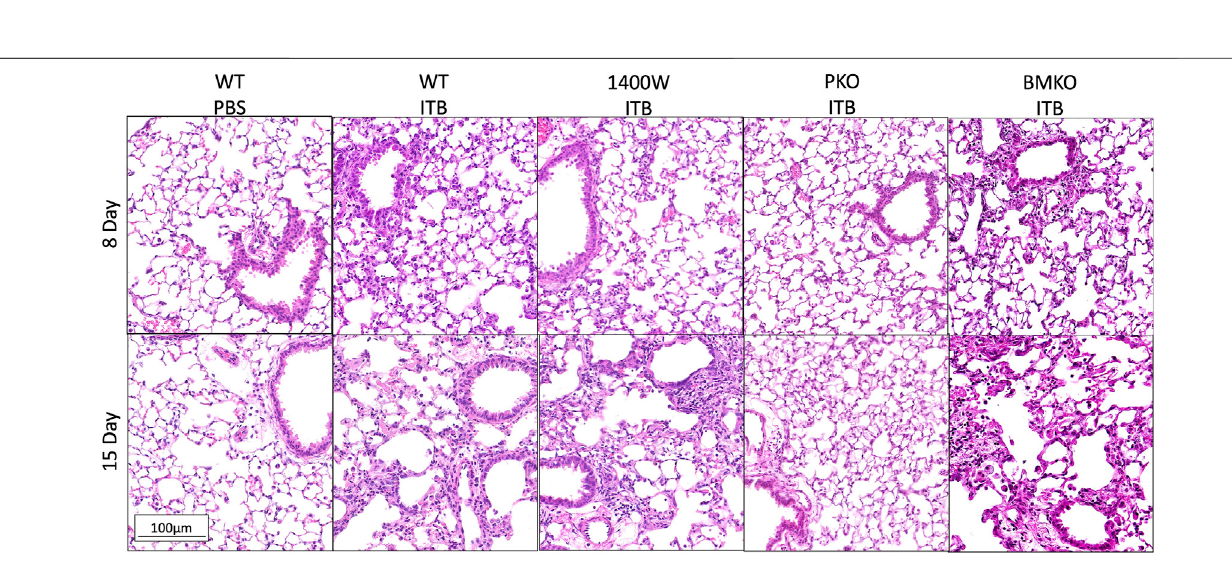
Frontiers in Pharmacology |